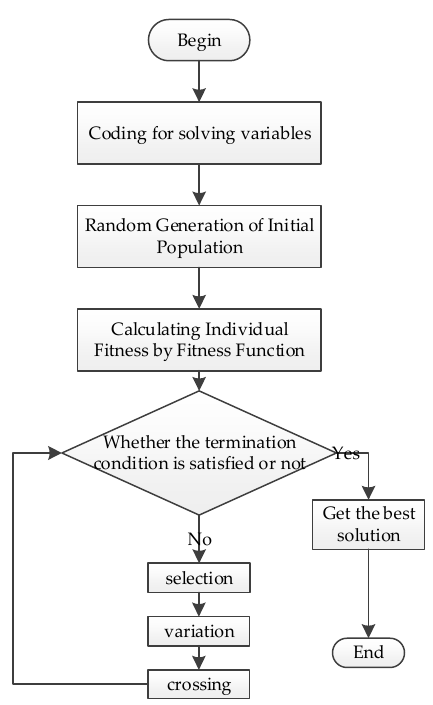
Figure 11. Flow chart of genetic algorithm.